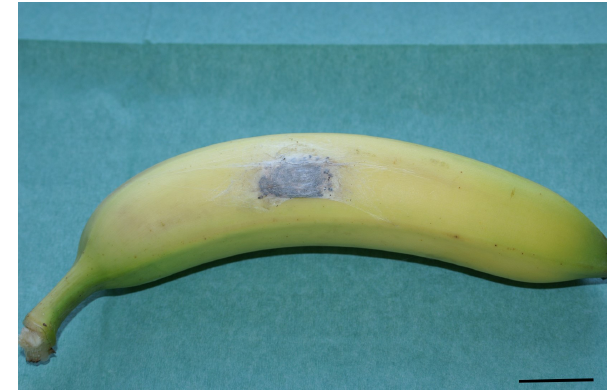
Figure 1. Banana delivered with a spider cocoon on the surface (scale bar = 4cm).